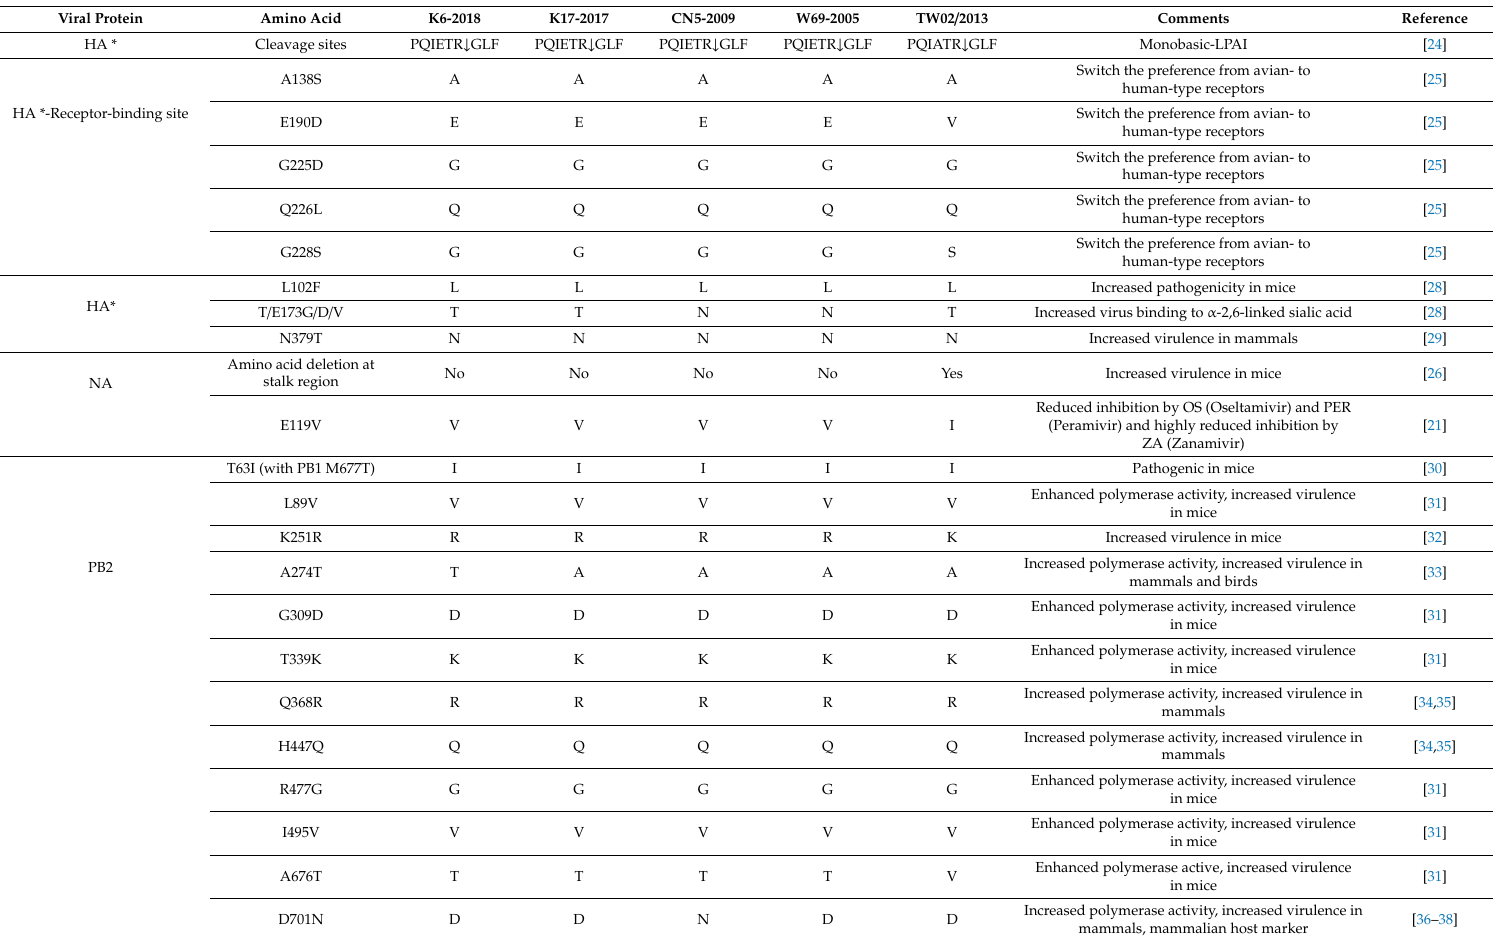
Table 2. Molecular characteristics of influenza A (H6N5) isolates used in this